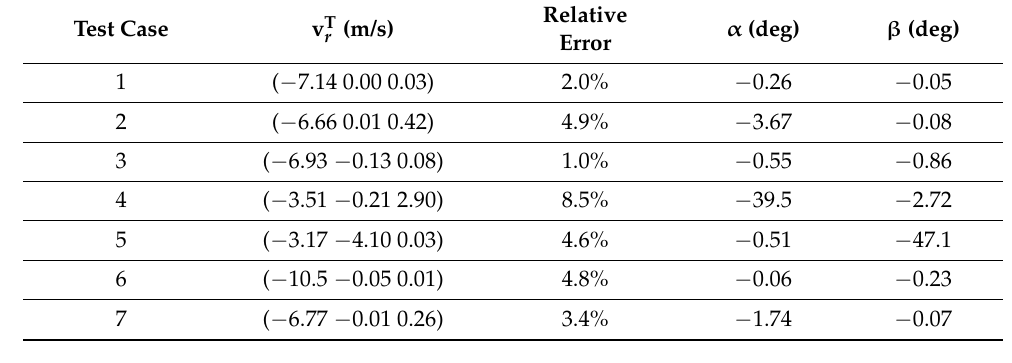
Table 6. Estimates of v r , AOA, and AOS in the seven experimental setups (filtered data).